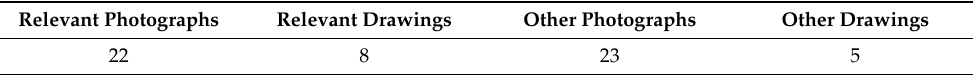
Table 1. Distribution of the final results for Taschenbergpalais yielded by LEA.